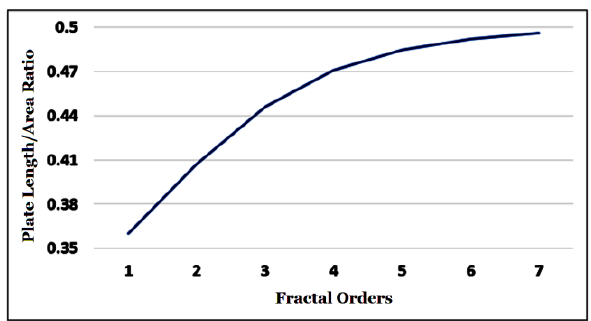
Figure 4. Ratio of plate length versus area under different fractal orders.